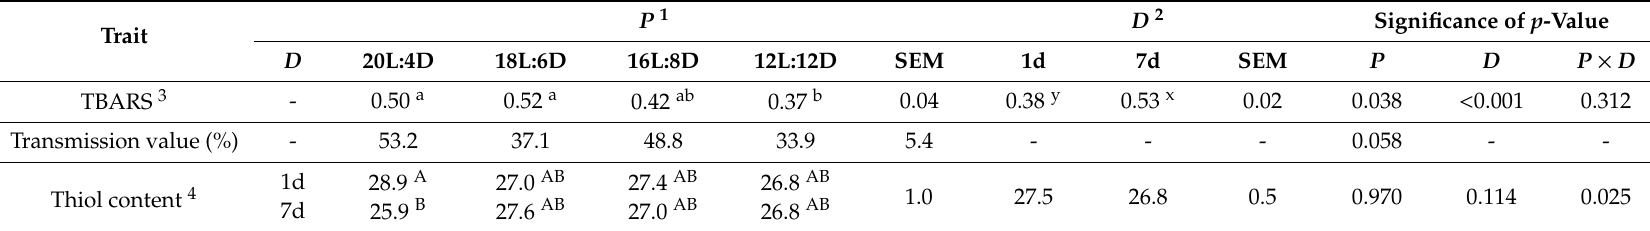
Table 5. E ff ect of photoperiod on the 2-thiobarbituric acid reactive substance values, thiol content, and transmission value of broiler fillet ( M. Pectoralis major ) muscles, during aerobic display storage ( n = 6 /